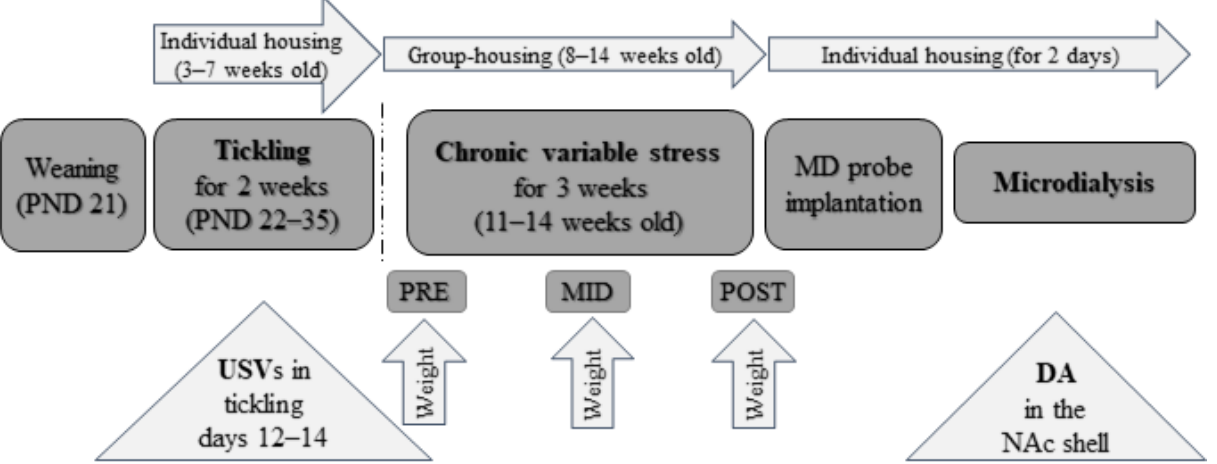
Figure 1. The general timeline of experimental procedures. DA, dopamine; MD, microdialysis; NAc, nucleus accumbens; PND, postnatal day; USVs, ultrasonic vocalizations.